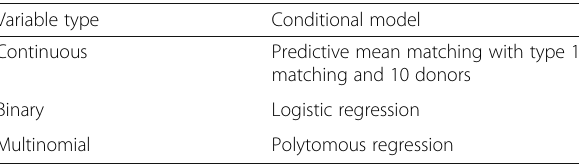
Table 2 Conditional models used in the multivariate imputation by chained